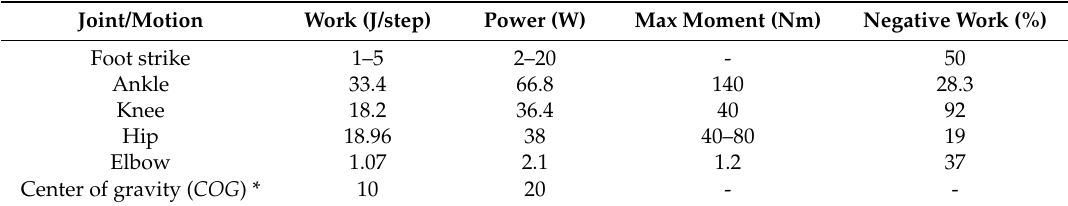
Table 1. Biomechanical power from human motion